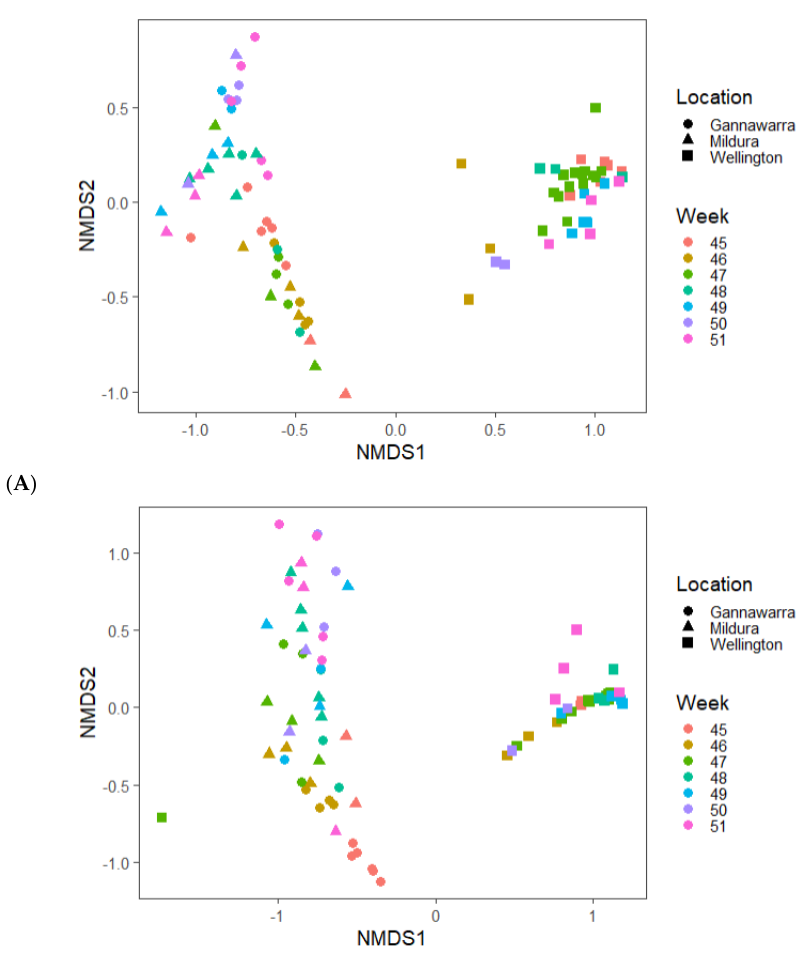
Figure 8. Non-metric multidimensional scaling (NMDS) based on Bray–Curtis dissimilarity of the ( A ) viruses and ( B ) mosquitoes in the trap subsamples from three locations over seven weeks showing a separation between coastal (Wellington) and inland (Gannawarra and Mildura) samples.